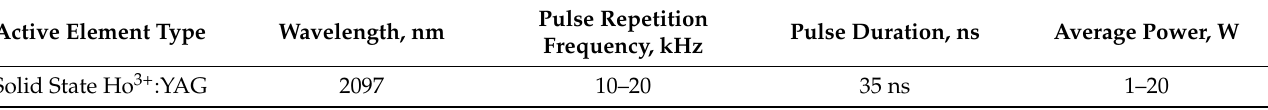
Table 3. Ho 3+ :YAG laser parameters.